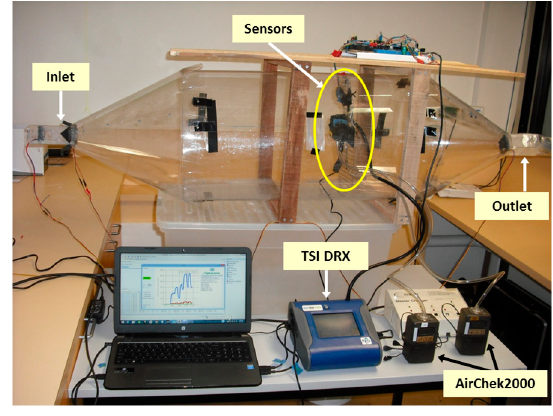
Figure 5. Set up of monitoring devices and dust chamber for calcined alumina calibration tests.